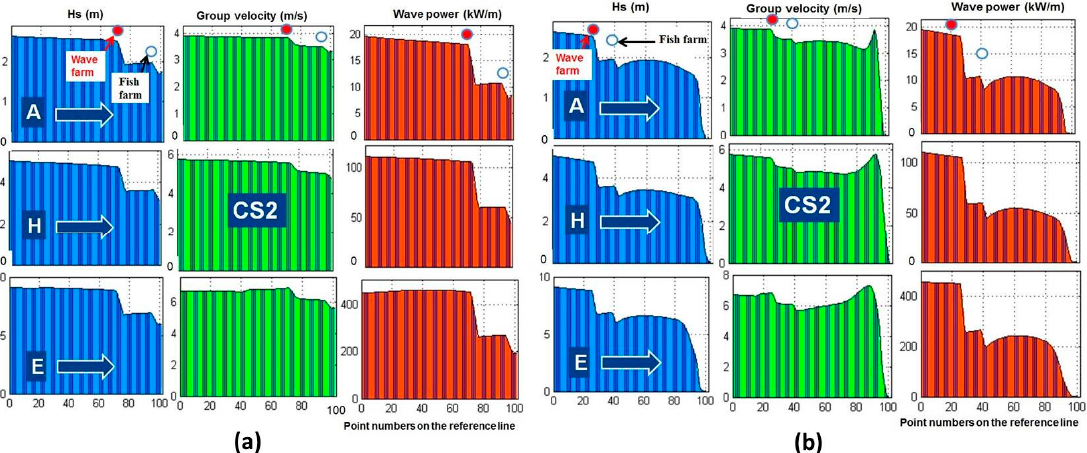
Figure 7. CS2 (realistic scenario for the wave farm), results of the SWAN model simulations along the reference lines (RL1 and RL2). The wave parameters represented are: significant wave height, group velocity, and wave power. The reference lines are divided into 100 points equally spaced. ( a ) Model results along RL1; ( b ) model results along RL2. A—average wave conditions, H—high wave conditions, E—extreme wave conditions. The locations of the wave and fish farms are indicated in the upper figures with red and white circles, respectively.